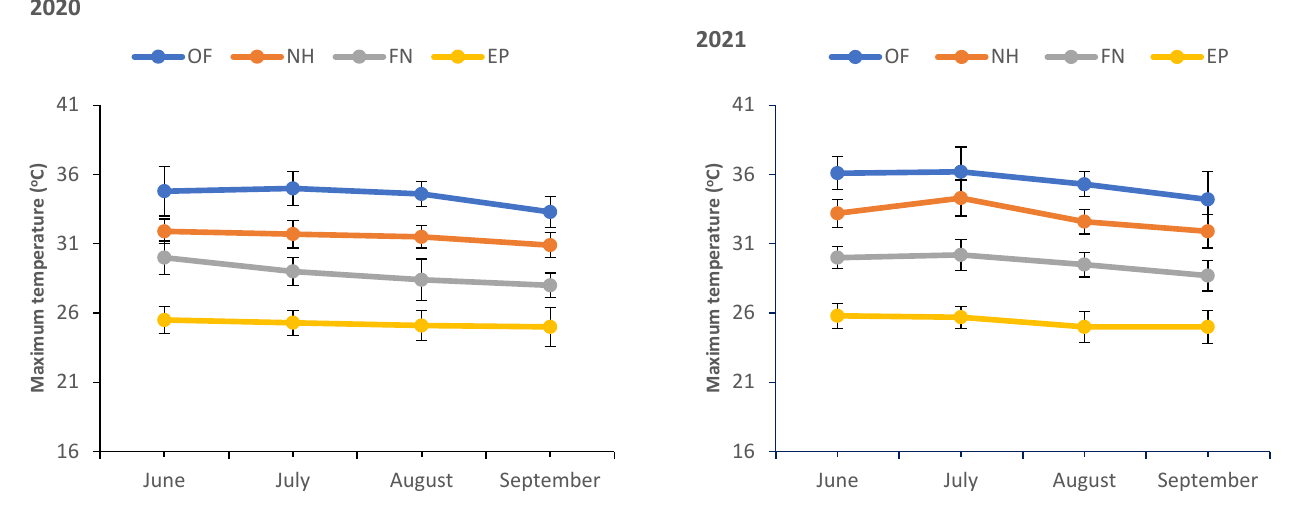
Figure 4. Average monthly maximum temperature during the experiment periods of 2020 and 2021 seasons, registered in the open field (OF), net house (NH), net house with fogging (NF, operating 6 S/36 S from 10 a.m. to 4 p.m.) and evaporative cooling under plastic house (EP). Standard error of the means was derived from three biological replicates.